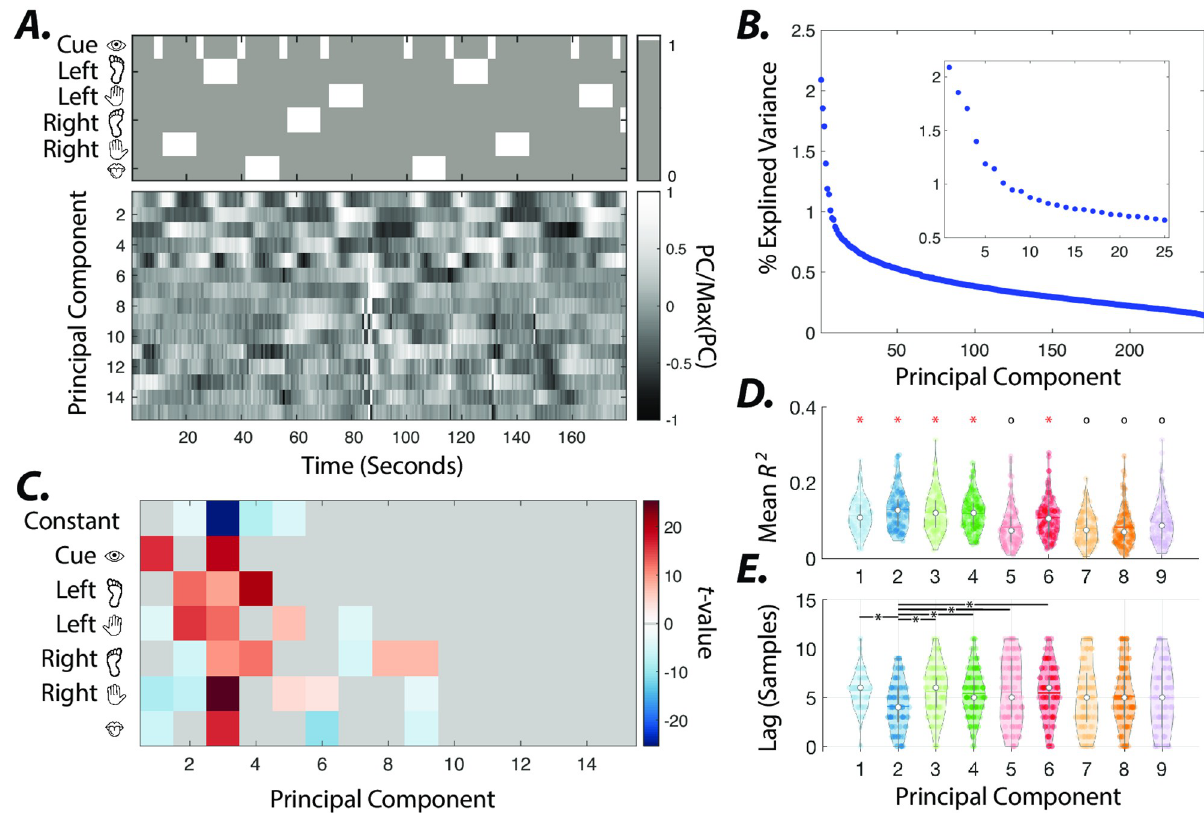
Fig 6. Principal component analysis of estimated external inputs. (A) Group-level principal components (PCs) 1–15 calculated from concatenated estimated inputs (input matrix B dimension = 25) across all subjects. Top plots show onsets and durations of visual cues and motor task conditions. (B) Percent variance explained by PCs. Insets depict the percent variance explained by PCs 1–25. (C) t -values calculated from coefficients of multiple linear regression models of estimated external inputs associated with each PC (see methods for details). The average coefficients that fail to pass the significance-level across subjects ( t − test, p < 0.05, Bonferroni corrected for multiple comparisons) are depicted in gray. (D) Distributions of R 2 values of multiple linear regression models in panel B for components with significant coefficients. White circles and color-coded horizontal bars indicate the medians and means of distributions, respectively. Pairwise comparison (Wilcoxon rank-sum test, p < 0.05, FDR corrected for multiple comparisons) between distributions reveal that R 2 values for principal components marked by red ‘ � ’ are significantly higher than those marked by black ‘o’ (except for the non-significant difference between PC 1 and PC 9). (E) Distributions of the number of lags (samples) that results in best fit (i.e., maximum R 2 ) for PCs 1–9. We used the mean (round to nearest integer) of optimal subject-level lags for analysis in panels C and D .